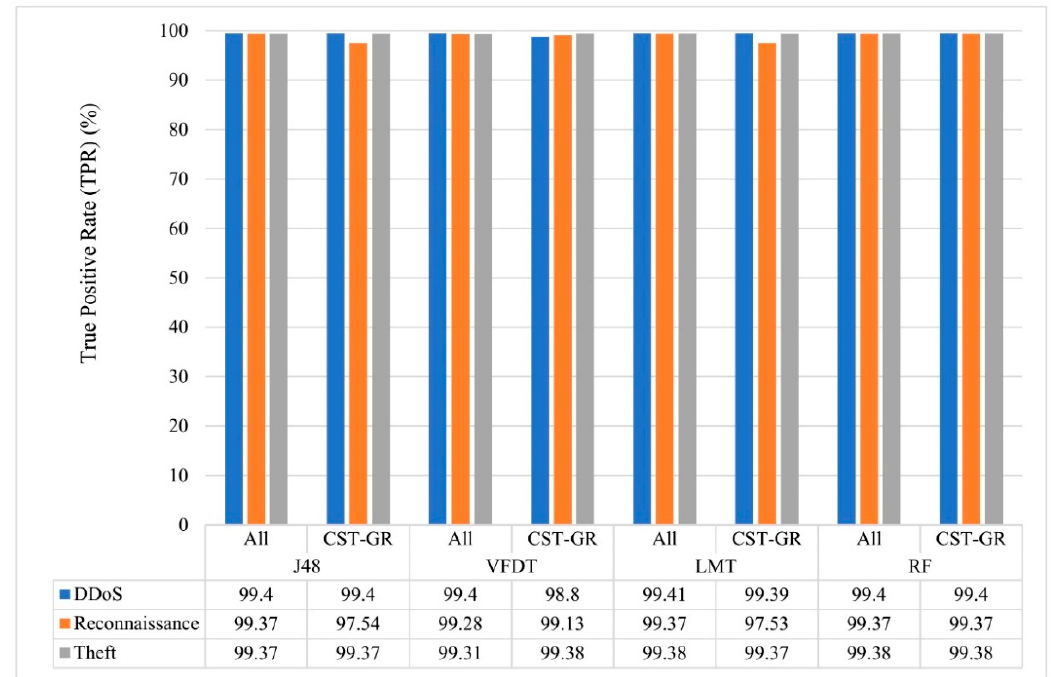
Figure 4. A comparison of TPR of J48, very fast decision tree (VFDT), logistic model tree (LMT), and random forest (RF) between the cases using all features and using CST-GR selected features for each kind of attack.